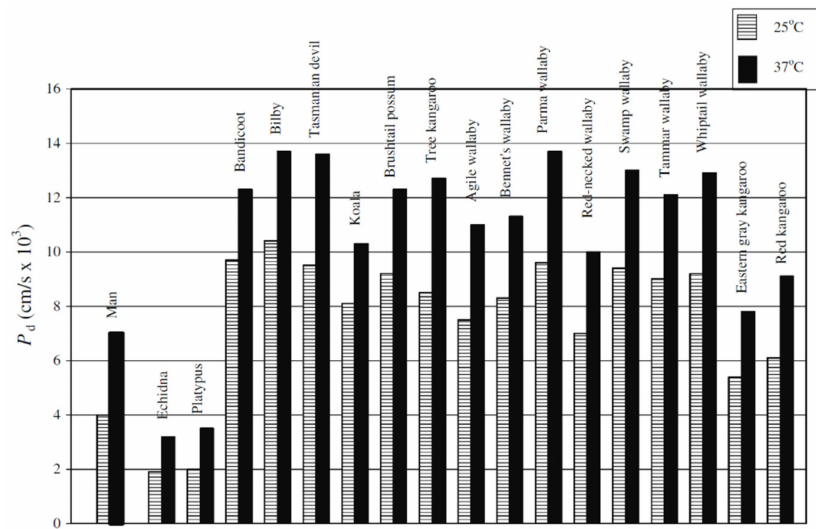
Figure 57. Values of the permeability P of RBCs of humans and some laboratory animals and pets for water at 25 and 37 ◦ C. Reprinted with permission from [156]. Copyright 2012 Springer Nature.